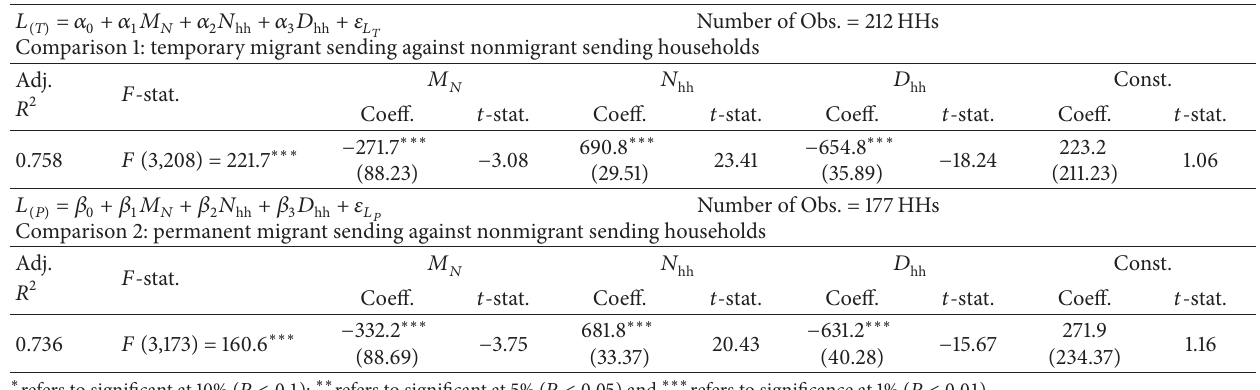
Table 1: Stage 1 estimation result for the determinants of labor input (for comparison of both temporary and permanent migrant sending